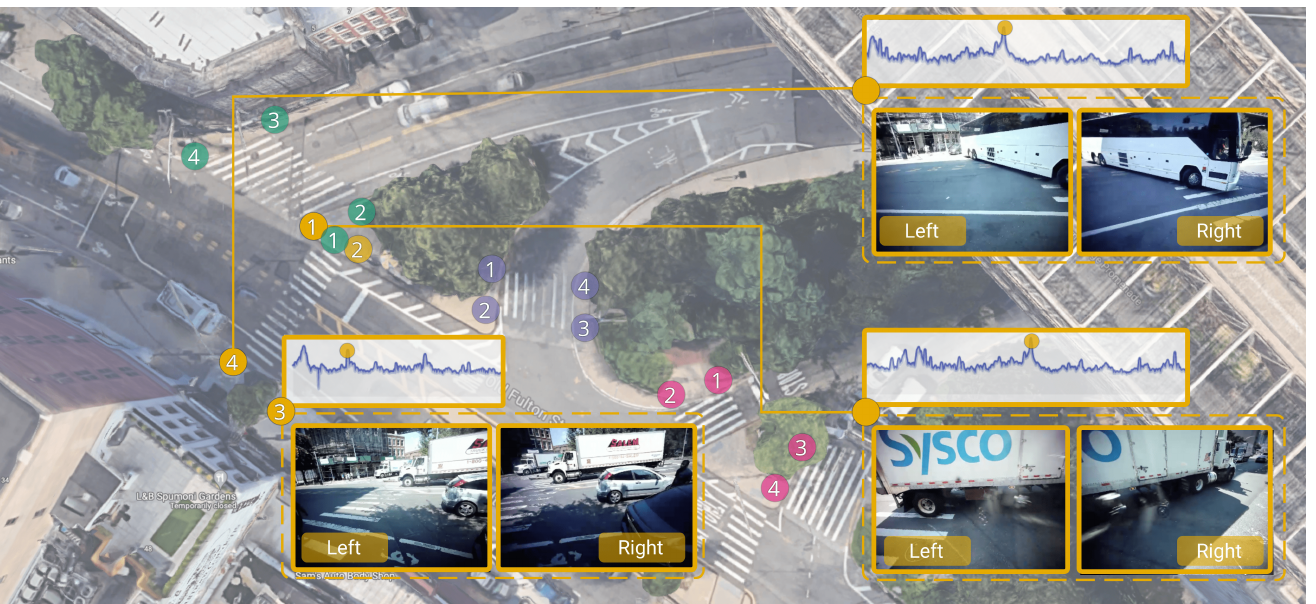
Figure 12. Sensor positions during data acquisition at DUMBO, Brooklyn. Colors indicate recording sessions and numbers denote the sensor. Above each synchronized video frame, we highlight the relative data point in the audio time series (in decibels). It can be shown that events that can be seen in the video, such as the passing of a bus, have a corresponding peak in the audio